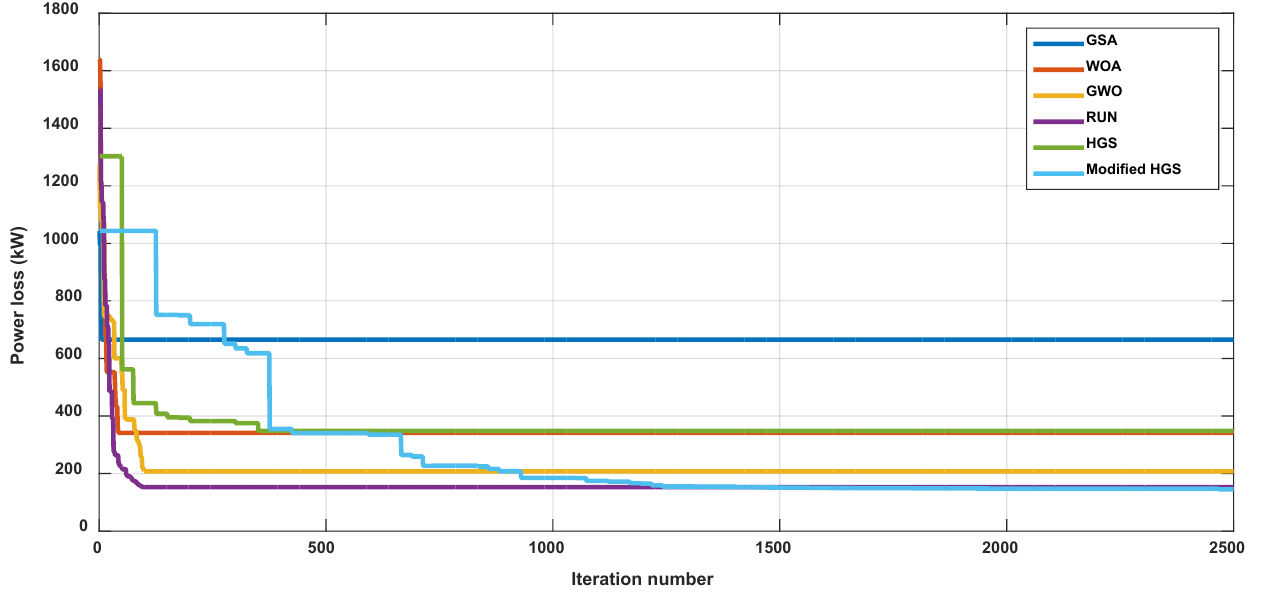
Figure 12. Convergence curves of power loss against iteration numbers of different optimizers applied to the IEEE 119-bus.